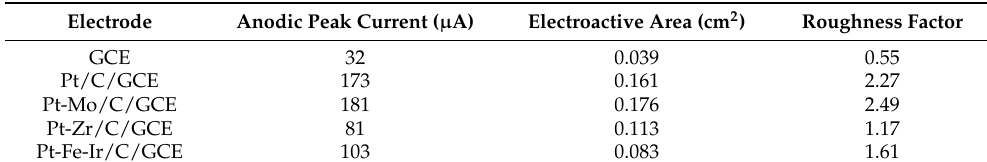
Table 2. Comparison of electroactive area and roughness factor for various electrodes.